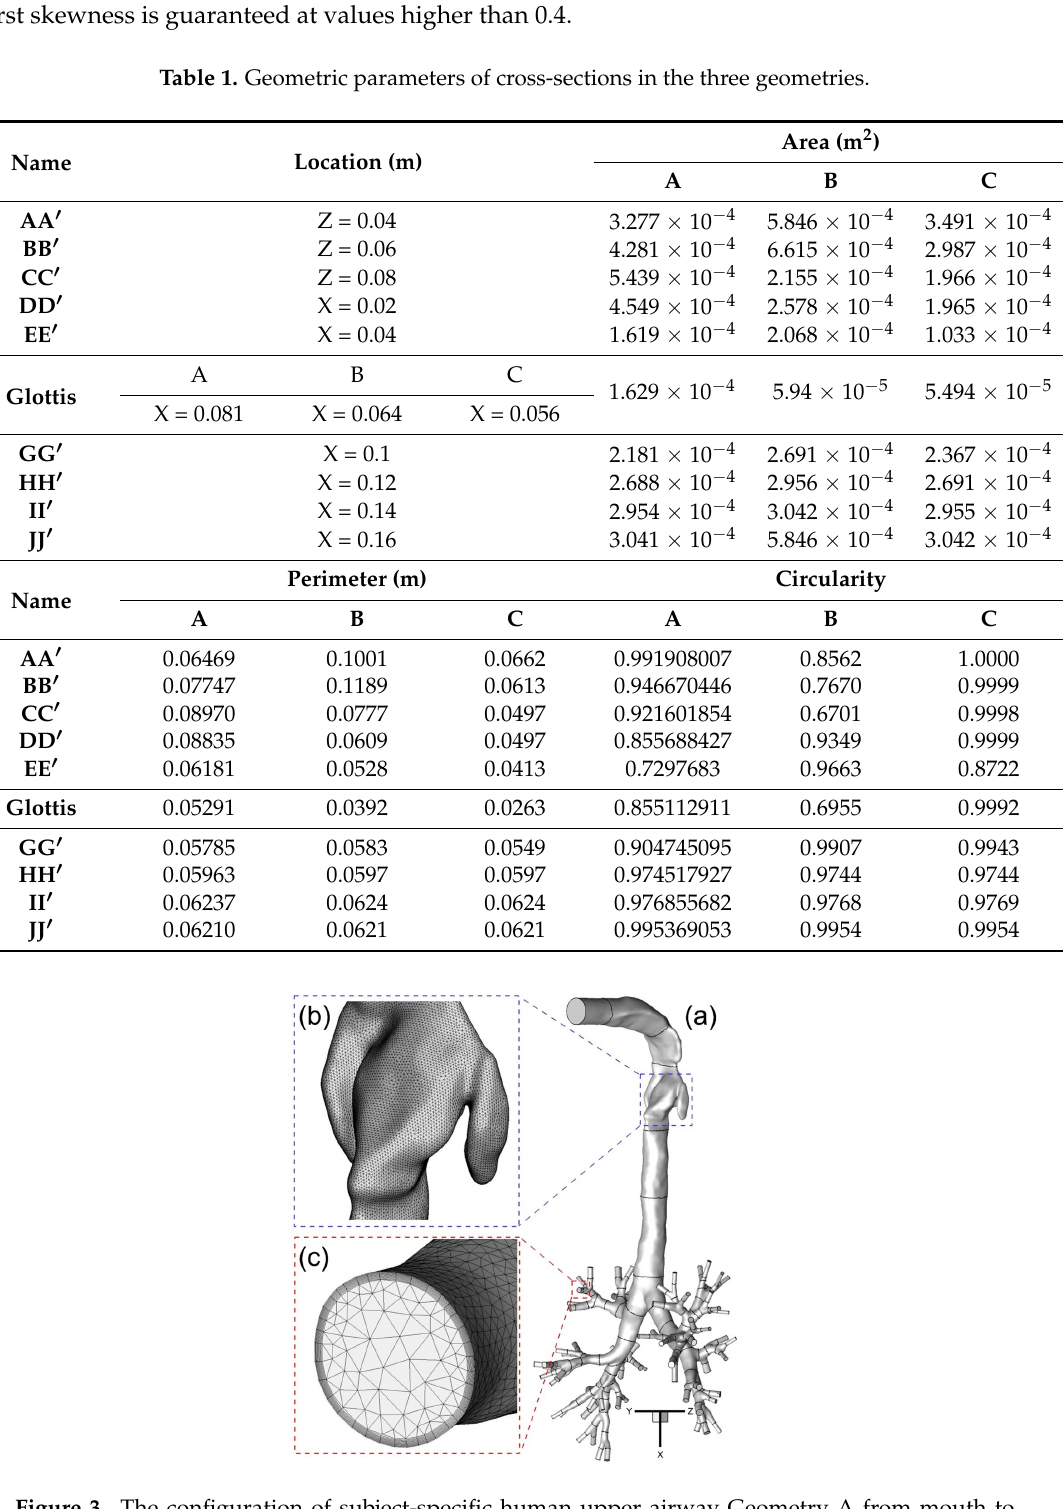
Table 1. Geometric parameters of cross-sections in the three geometries.